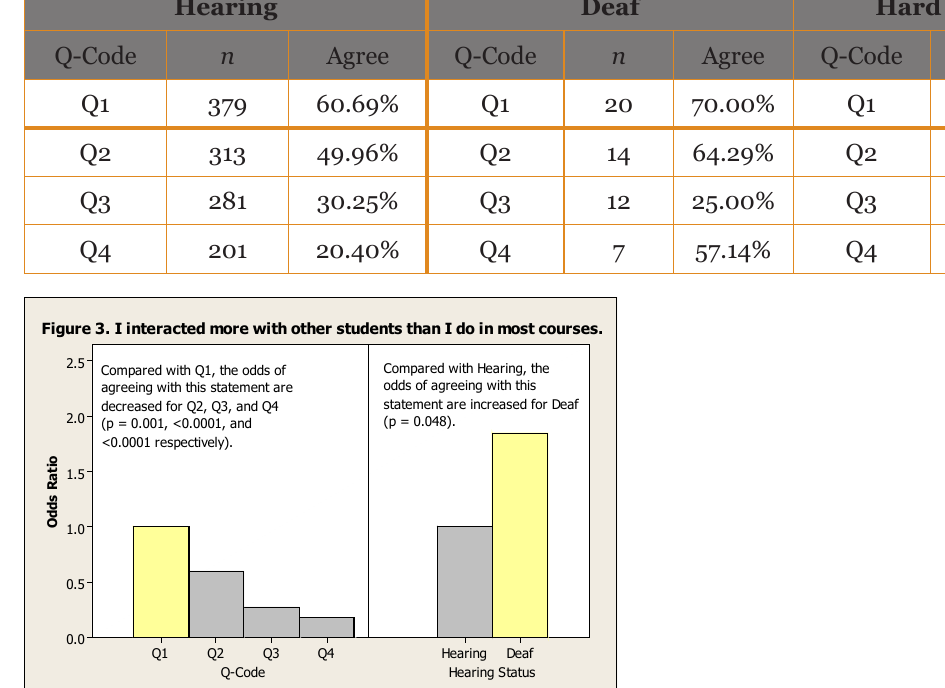
Figure 3 . Odds-Ratios for “I interacted more with other students than I do in most courses.”